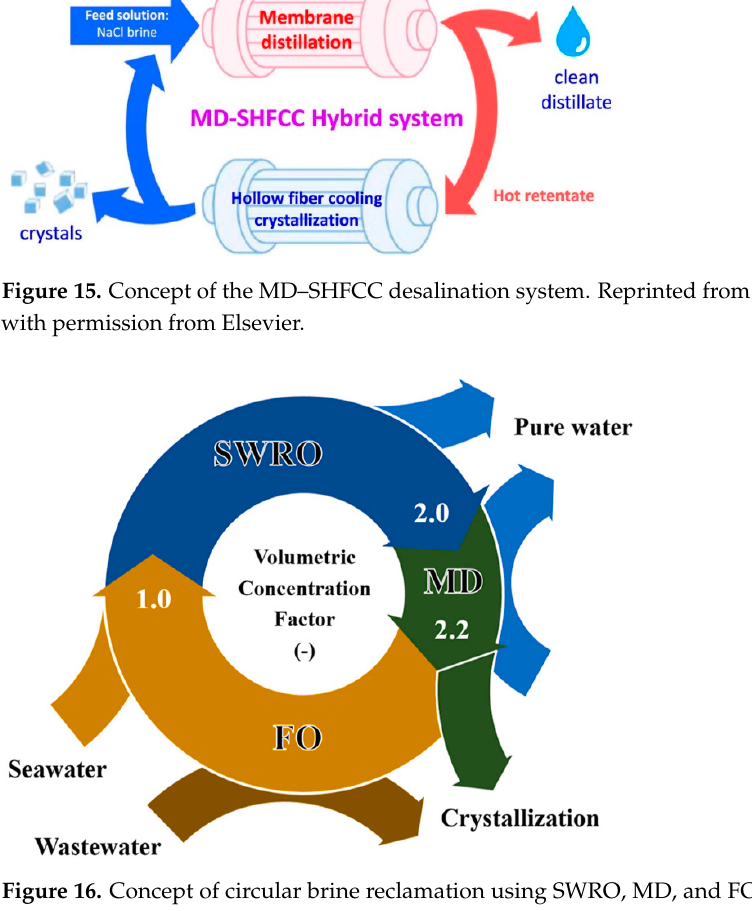
Figure 16. Concept of circular brine reclamation using SWRO, MD, and FO. Reprinted from [108]. Copyright (2021) with permission from Elsevier.